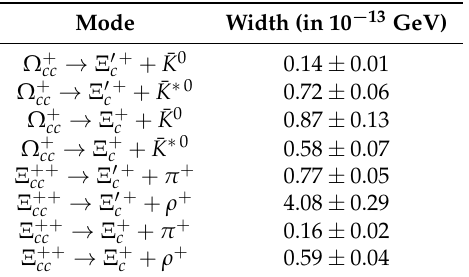
Table 9. Estimating uncertainties in the decay